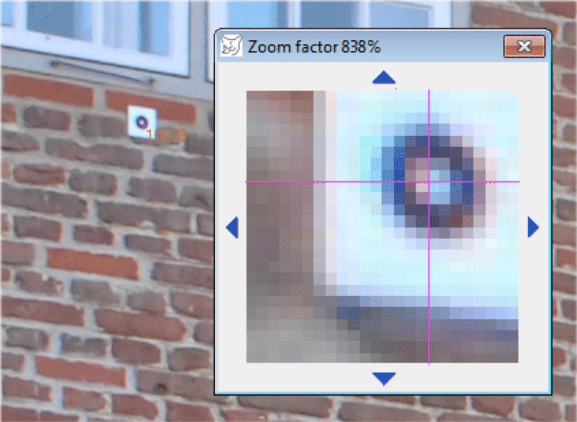
Figure 4: Manual image